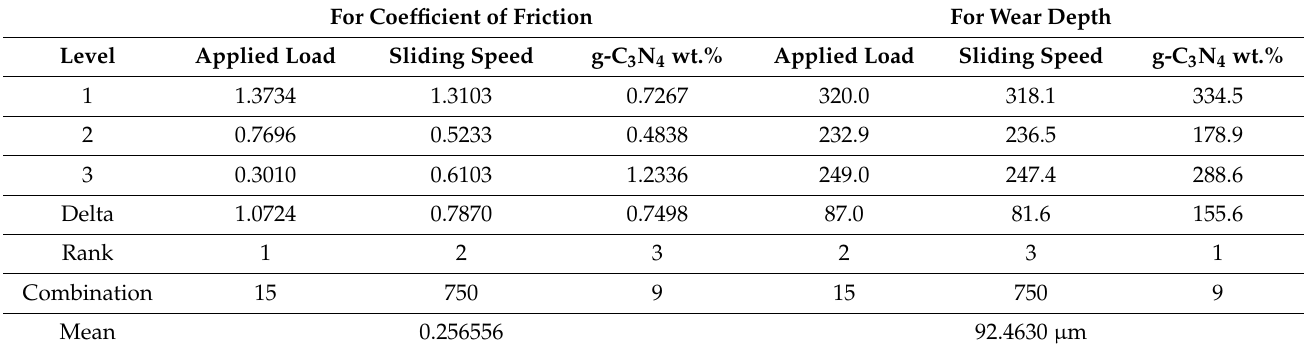
Figure 4. The main effect plots for SN ratios ( a ) COF and ( b ) wear depth at different parameters, such as applied load, sliding speed, and g-C 3 N 4 weight percentage in nanocomposite. Table 5. Response table for SN ratio for COF, wear depth, and the corresponding rank of process parameters.